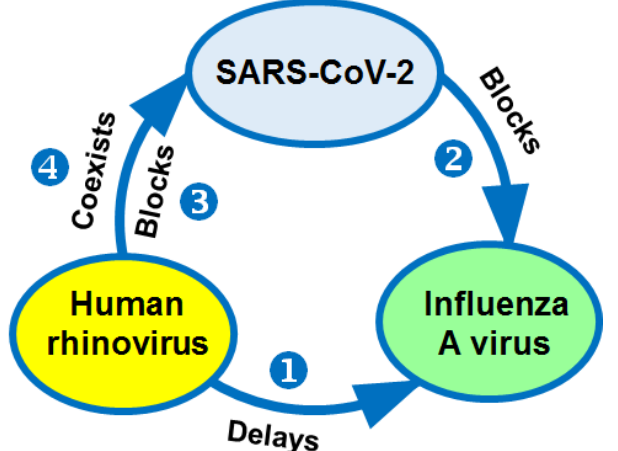
Figure 2. Interactions between human rhinoviruses, influenza A virus, and SARS-CoV-2 (based on the results and suggestions of [10,126,128,163,165] ).